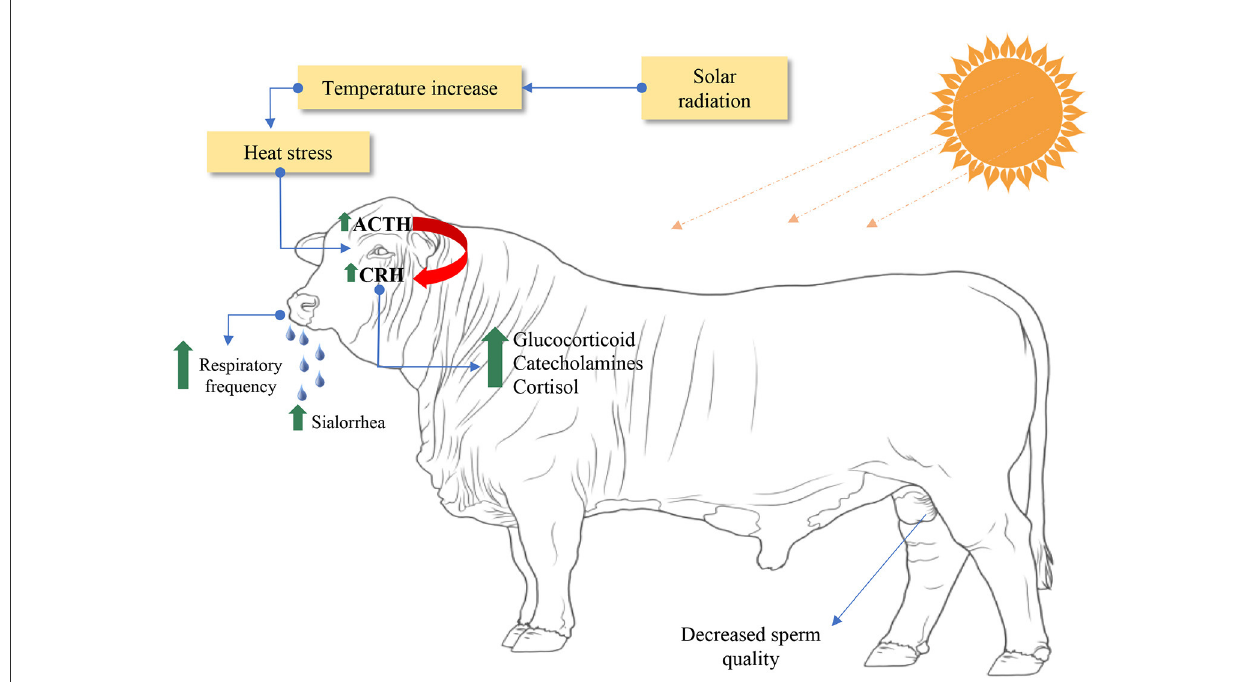
FIGURE12 Illustration of the effects of heat stress on male bovine reproduction. ACTH, adrenocorticotropic hormone, or corticotropin; CRH, corticotropin releasing hormone. Adapted from Krishnan et al. (37) and Singh et al. (172).